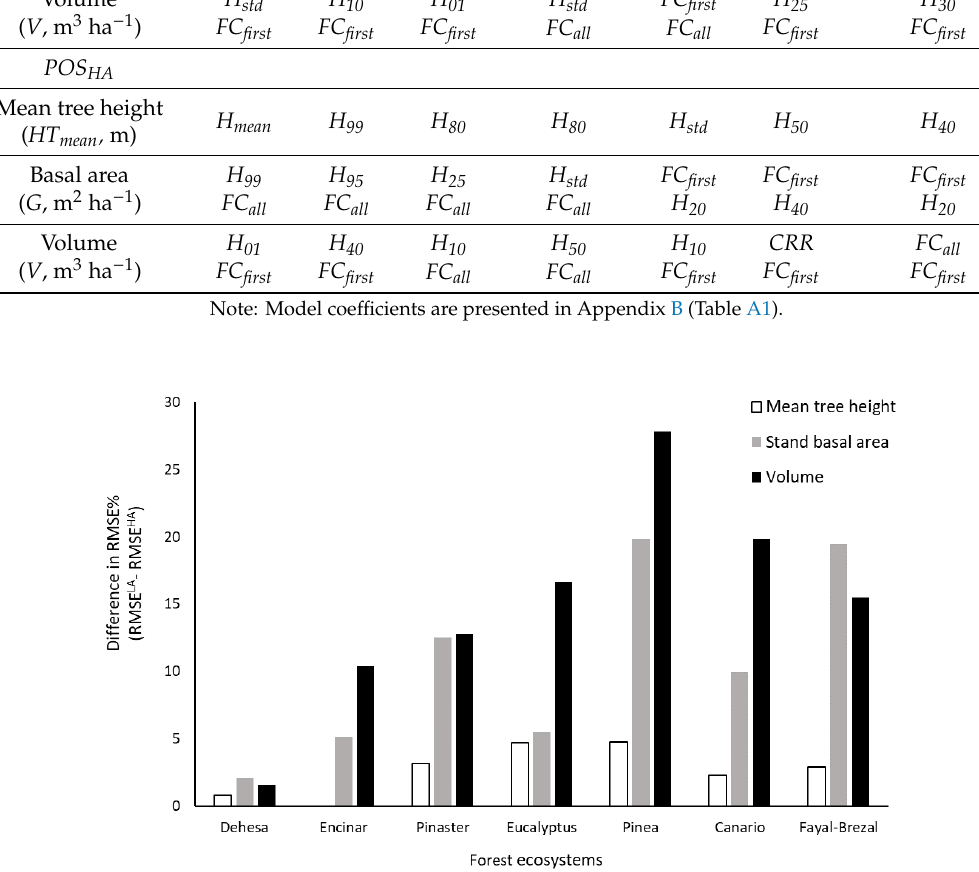
Figure 4. Variation in RMSE% accounted as the difference between traditional low-accuracy positioning ( POS LA ) and high-accuracy positioning ( POS HA ).